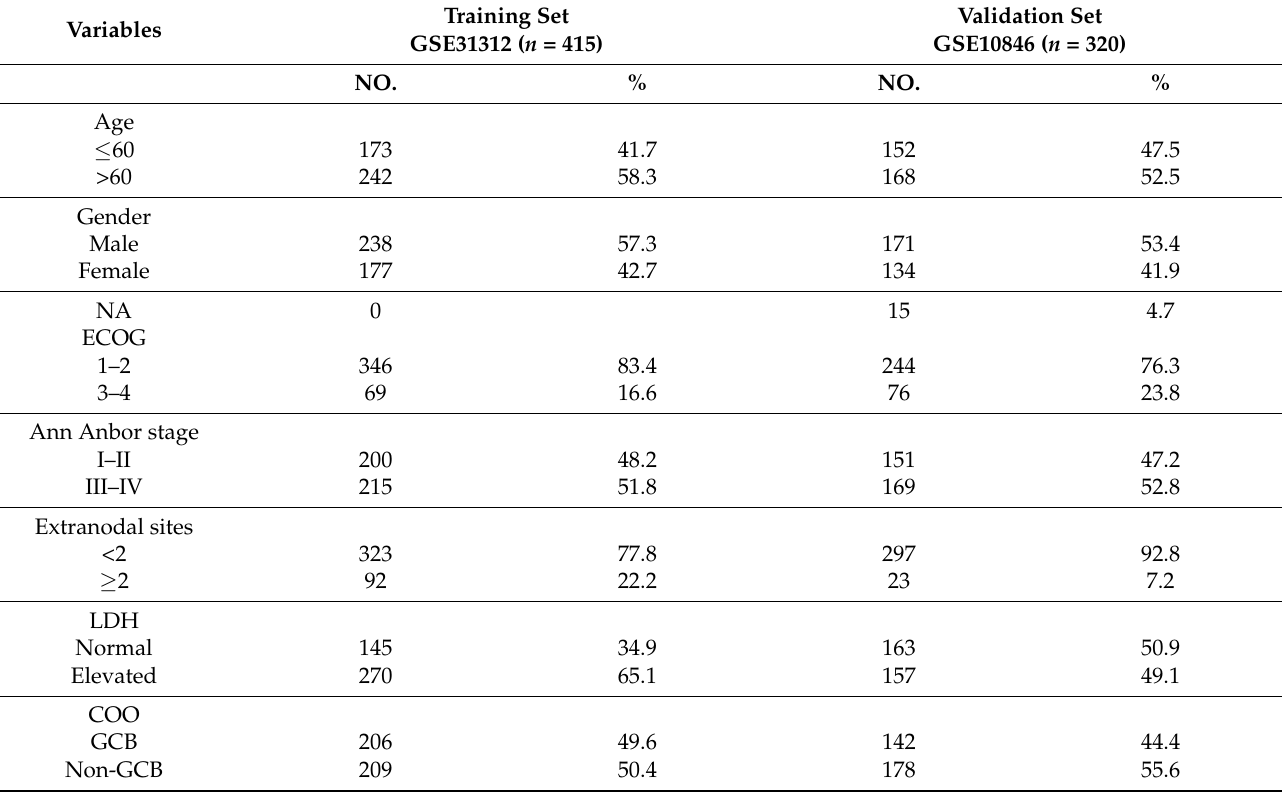
Table 1. Patients’ clinical features from the training set and validation